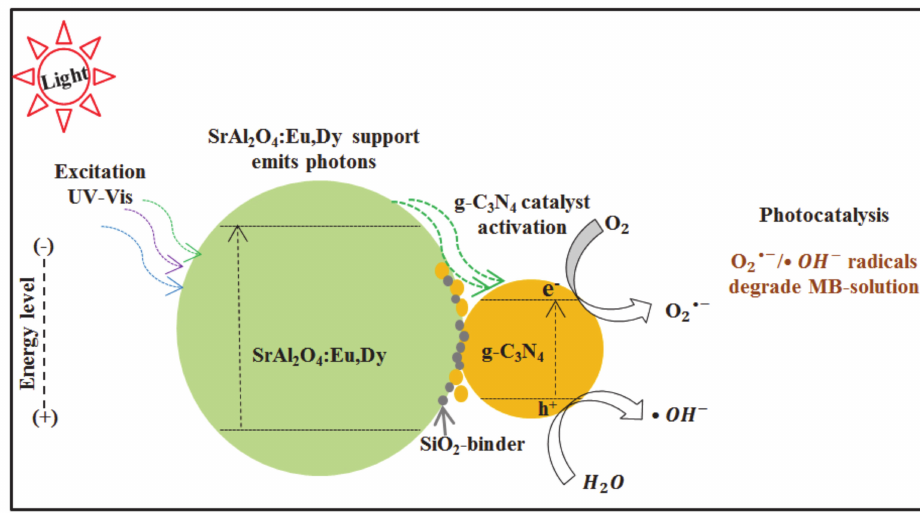
Figure 11. Schematic diagram for photocatalysis mechanism for the MB-SrAl 2 O 4 :Eu,Dy-SiO 2 / g-C 3 N 4 photoreaction